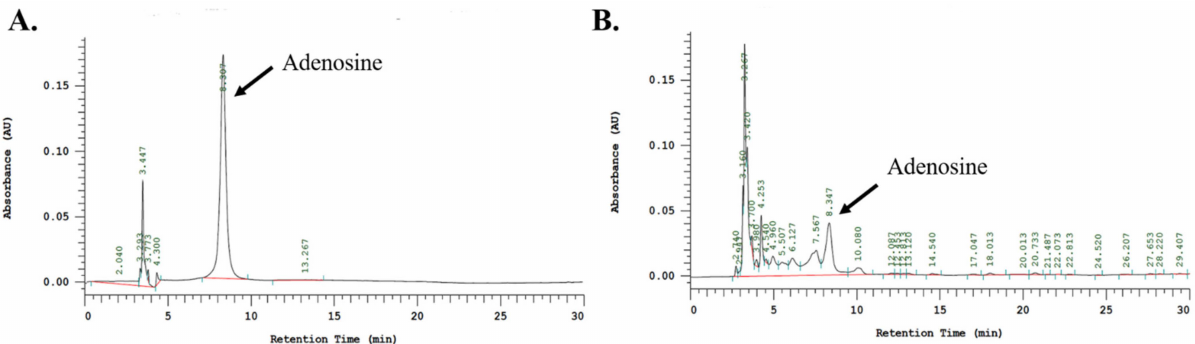
Figure 8. HPLC chromatogram of SC. The highlighted peaks indicate adenosine (8.3 min). HPLC chromatograms of ( A ) adenosine marker substances ( B ) aqueous extract of Schizophyllum com- mune